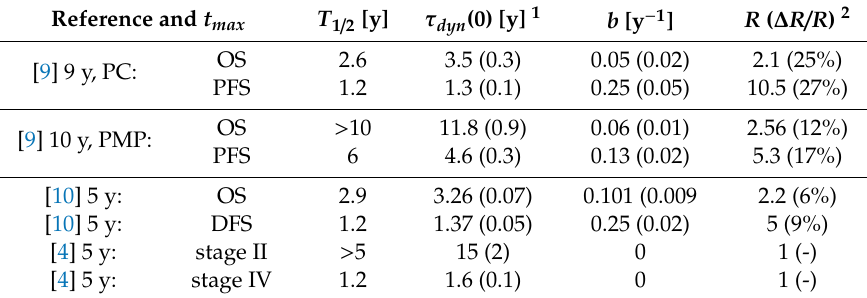
Table 1. Studies in terms of T 1 / 2 , τ dyn (0) = τ 0 , b and R for: (i) HIPEC selected on PC and PMP from [9]; (ii) PC from [10]; and (iii) relative survival S c ( t ) = S co / S o of the rectal cancer from [4].